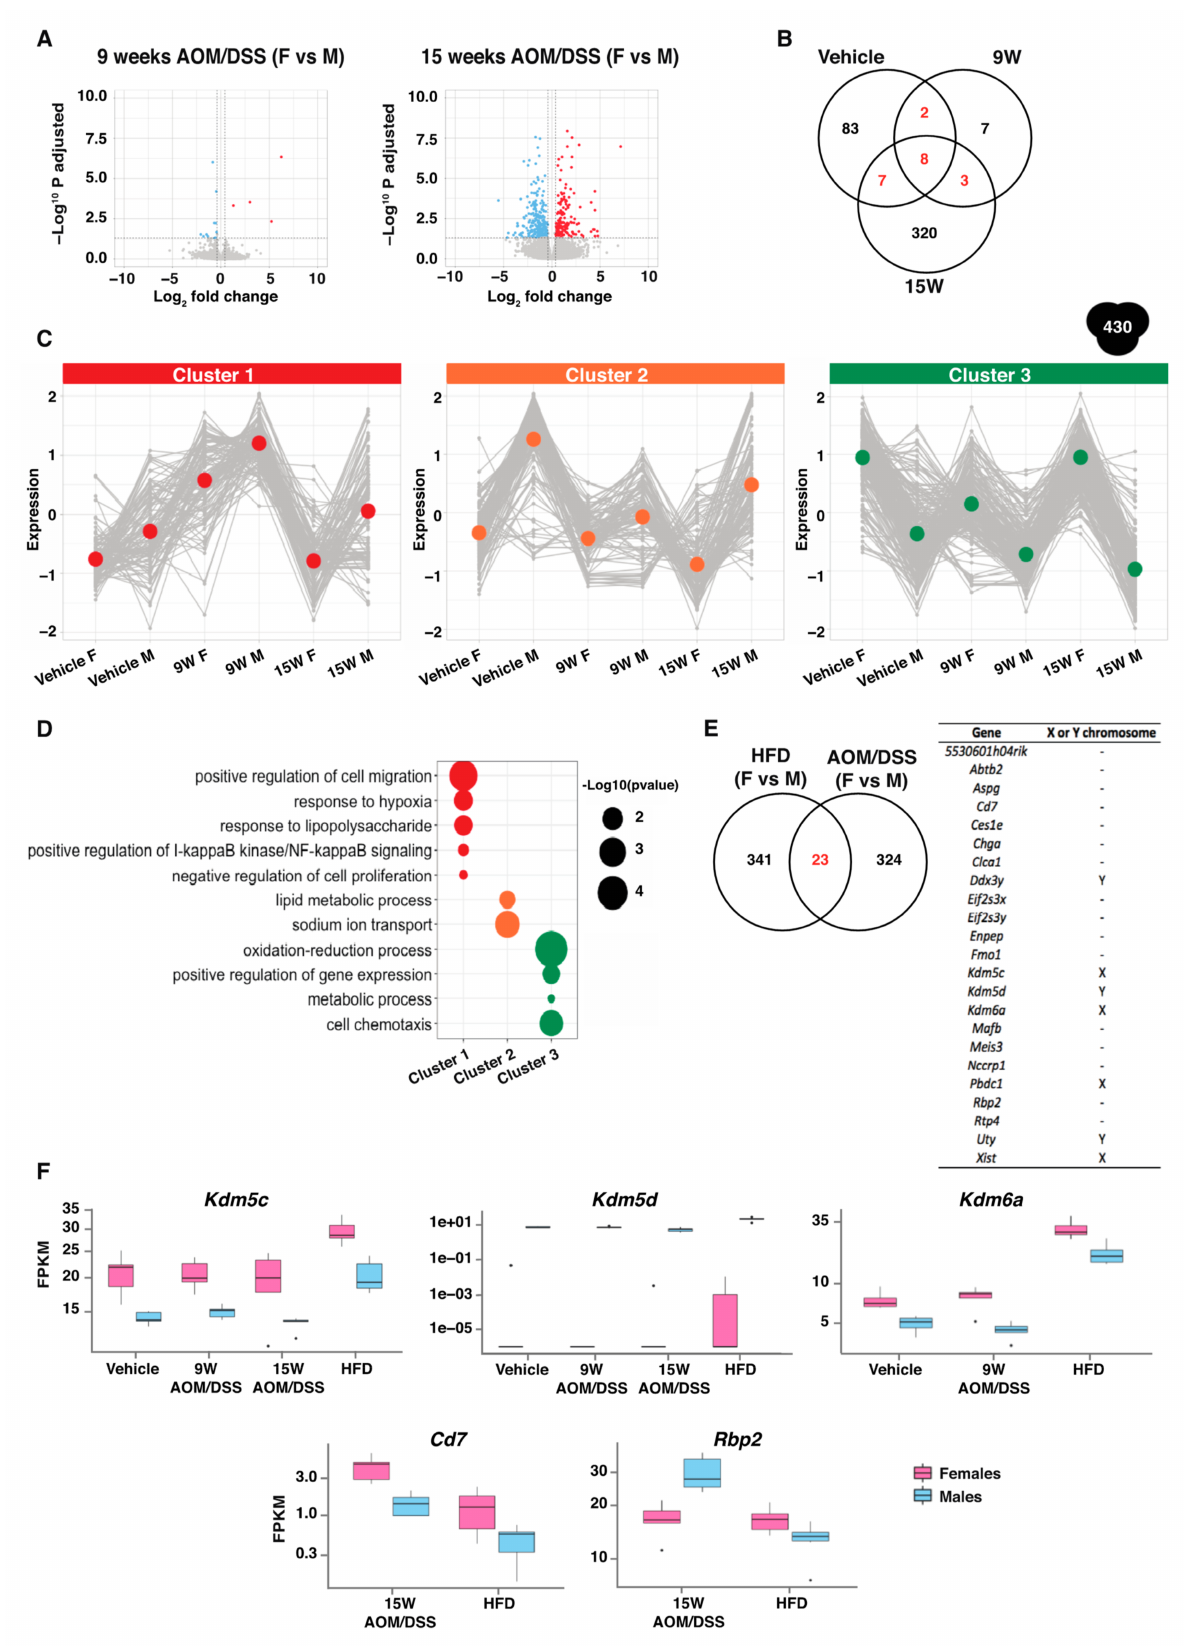
Figure 4. The largest sex differences were seen after 15 weeks of AOM/DSS treatment. ( A ) Volcano plot showing the DEGs between females and males during 9 and 15 weeks AOM/DSS